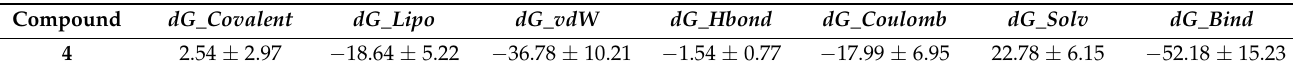
Table 4. Free binding energies and its components calculated from the MM-GBSA approach on octanoylbenzohydroquinone 4 .